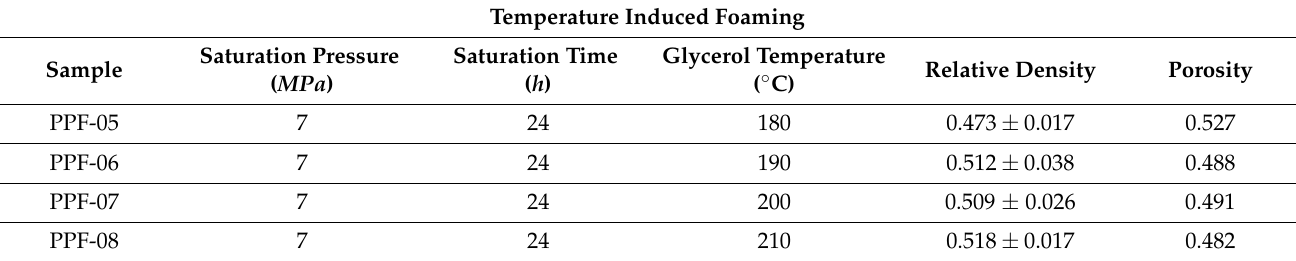
Table 2. Temperature induced in industrial rubber.